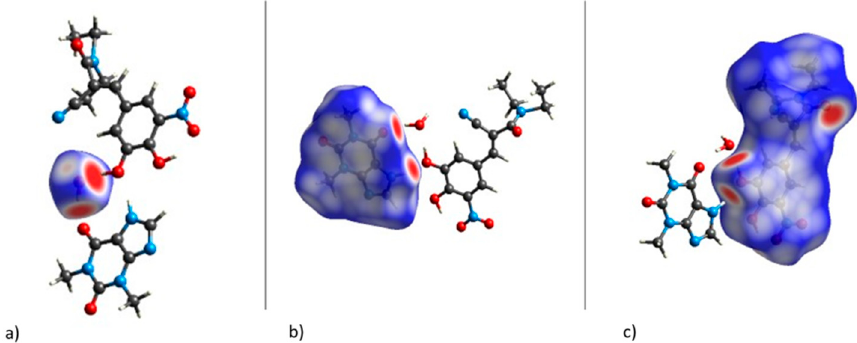
Figure 3. Hirshfeld Surfaces mapped over d norm for ( a ) water molecule, ( b ) THP molecule, and ( c ) ENT molecule, in the ENT-THP-water 1:1:1 cocrystal.